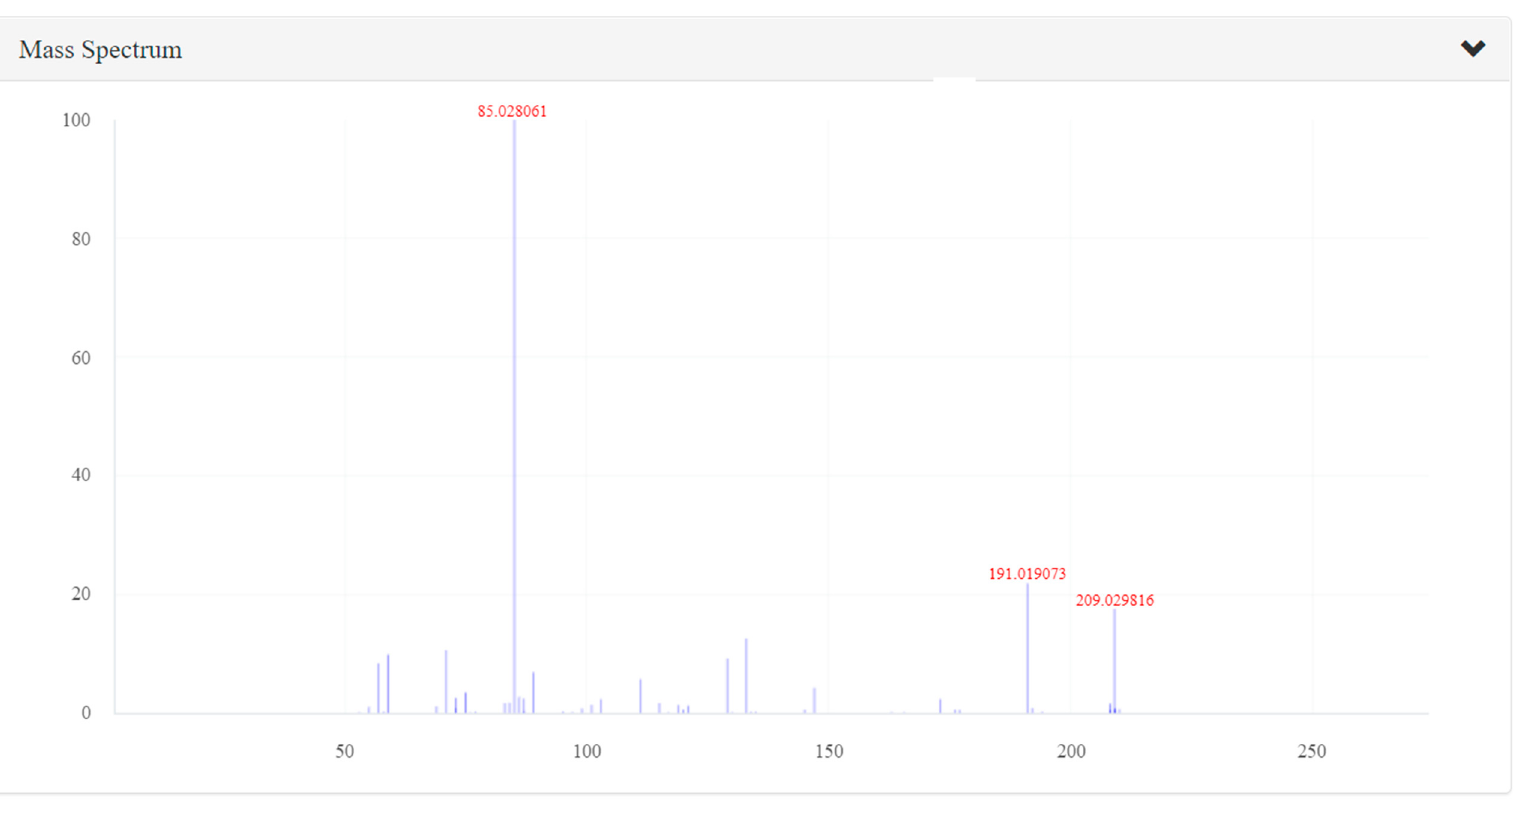
Figure 2. The LC-MS characterization of coumaoryl saccharic acid; ( A ) a chromatograph of p-coumaoryl saccharic acid (compound 5 , Table 1), retention time (RT = 8.98 min) in the negative mode of ionization (M − H) − tentatively identified in tender leaves, mature leaves, late maturity leaves, mature grains and flowers and not found in tender grains; ( B ) MS / MS spectrum of coumaoryl saccharic acid reflecting the product ion of m / z 93, confirmation via online LC-MS library and database.